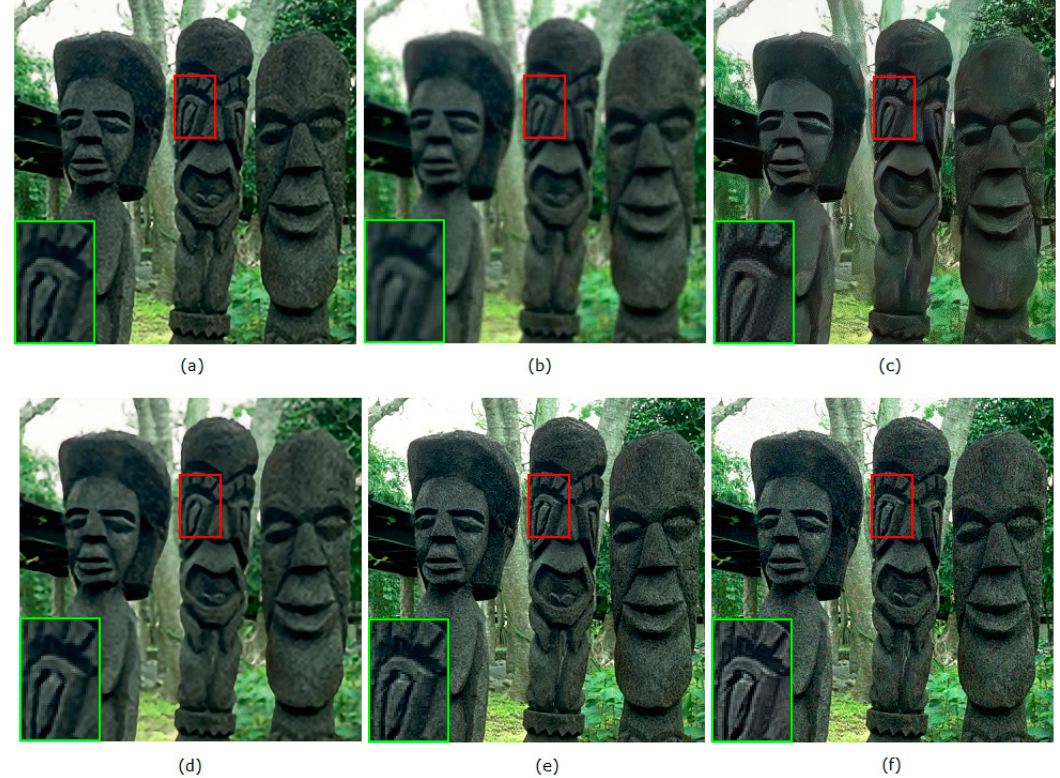
Figure 7. Visual quality comparison of speckle removal of the synthetic color image. ( a ) SAR-BM3D (27.10 dB); ( b ) SAR-CNN (27.52 dB); ( c ) ID-CNN (28.13 dB); ( d ) SAR-UNet (28.43 dB); ( e ) CCNN (28.67 dB); ( f ) CCNN+ (28.98 dB).